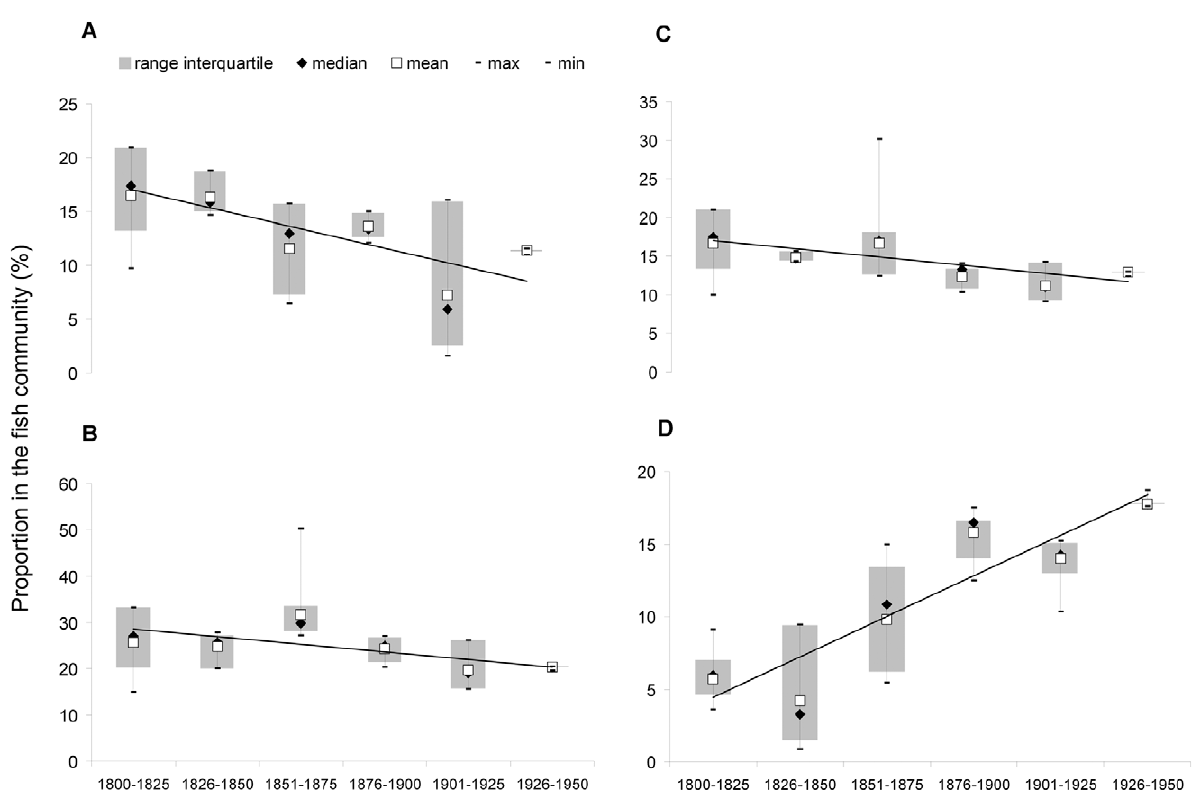
Figure 4. Temporal trends of fish community structure indicators in the period 1800–1950 (N=255 species). (a) Chondrichthyes; (b) large demersals; (c) species with a maximum body length between 120 and 250 cm; (d) species that reach sexual maturity within the 1 st year of